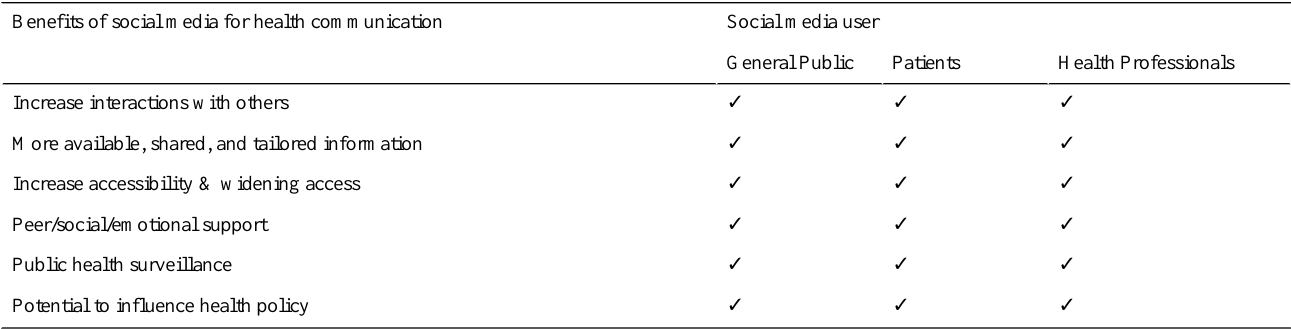
Table 4. Benefits of using social media for health communication for the general public, patients, and health professionals.